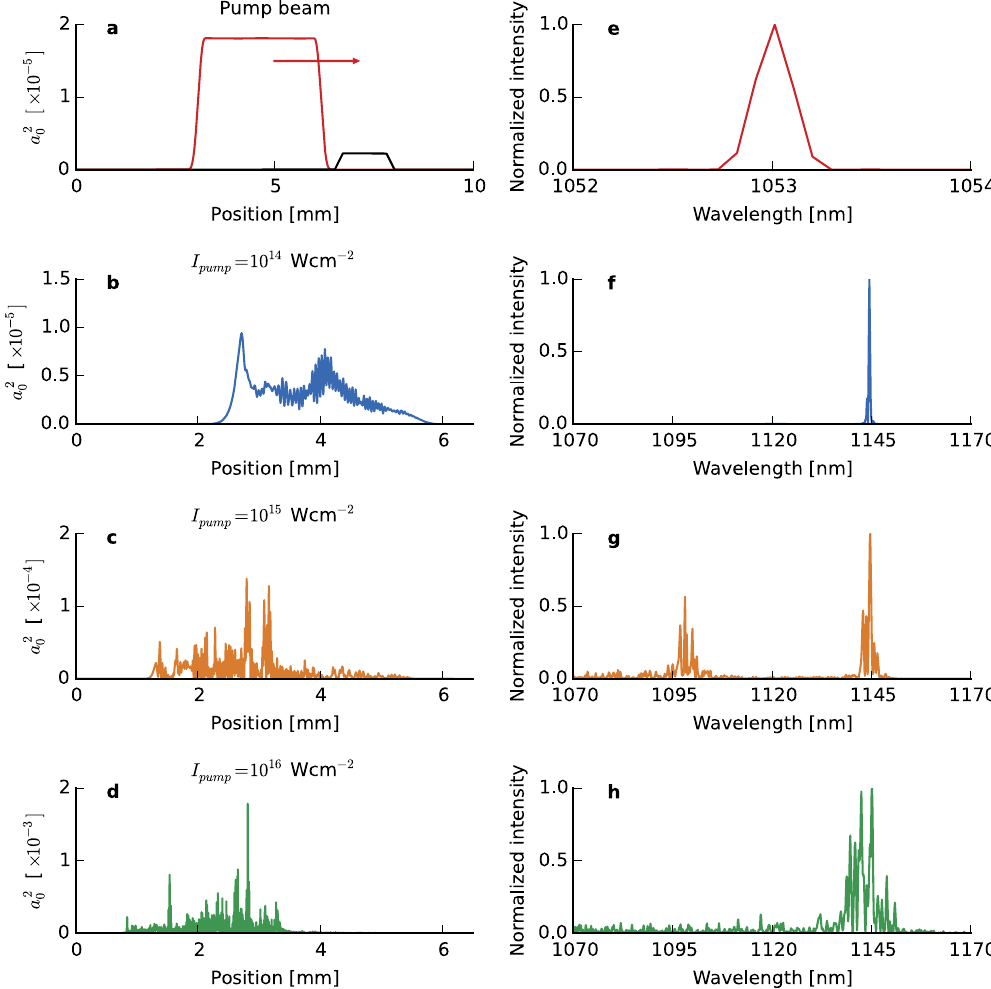
Figure 5. 1-dimensional simulation results. ( a ) (red) Initial pump envelope for an intensity of 1 × 10 14 W cm − 2 and ( e ) corresponding spectrum. In ( a ) is also shown (black) the position of the plasma. ( b–d) backscattered Raman signal for 3 different pump intensities ( a 0 ): 10 14 (0.01), 10 15 (0.03) and 10 16 cm − 2 (0.1), respectively. ( f–h ), Corresponding